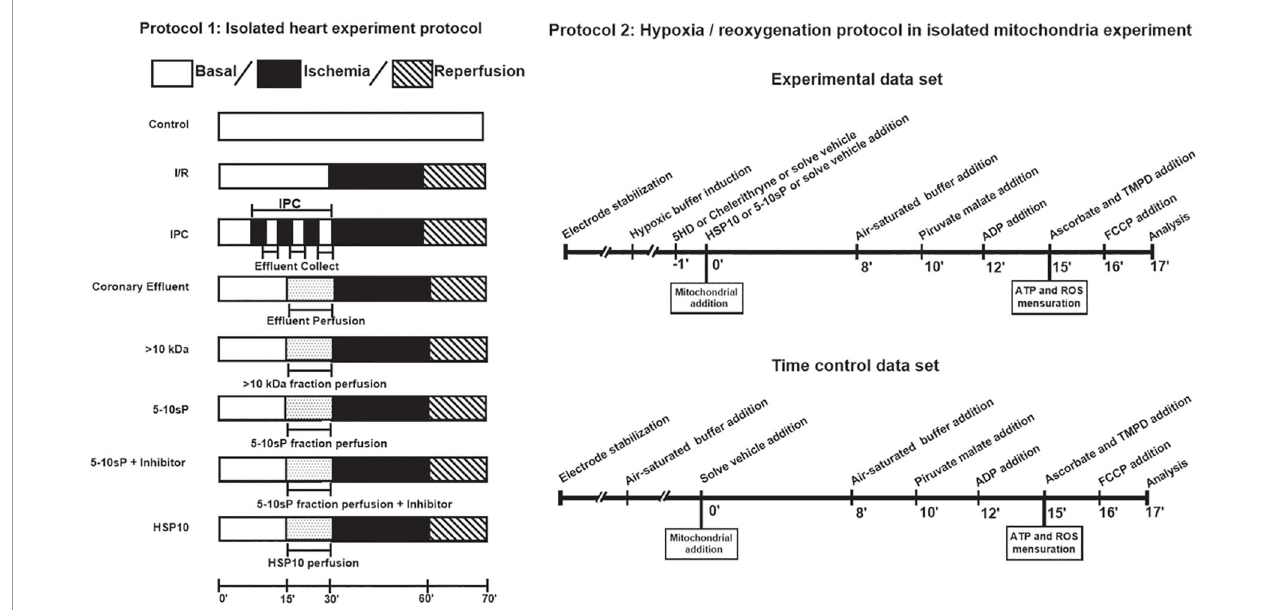
FIGURE 1 | Protocol 1 — Isolated heart experiment. IPC hearts were subjected to 3 cycles of 5 min global ischemia/5 min reperfusion. Coronary ef fl uent perfusion (CE) or its fractions were perfused in na ı ́ ve hearts for 15 min prior to ischemia/reperfusion. HSP10 was administered for 10 min before I/R. 5-hydroxydecanoate (5HD) or chelerythrine (Chel) were administered for 20 min, starting 5 min prior to 5 – 10 kDa fraction perfusion. Protocol 2 — Hypoxia/reoxygenation on isolated mitochondria. The buffer was made hypoxic. Mitochondrial proteins (300 m g) were added to the hypoxic buffer. After 8 min of hypoxia, O 2 -saturated incubation buffer was added to achieve reoxygenation for 2 min. After simulated hypoxia/reoxygenation or the respective normoxic time control (10 min), pyruvate and malate were given as substrates for complex I, mitochondria were stimulated with ADP and respiration was measured over 2 min. Finally, the mitochondria were used to either measure complex IV respiration and maximal uncoupled oxygen uptake, or extramitochondrial ROS concentration, or ATP